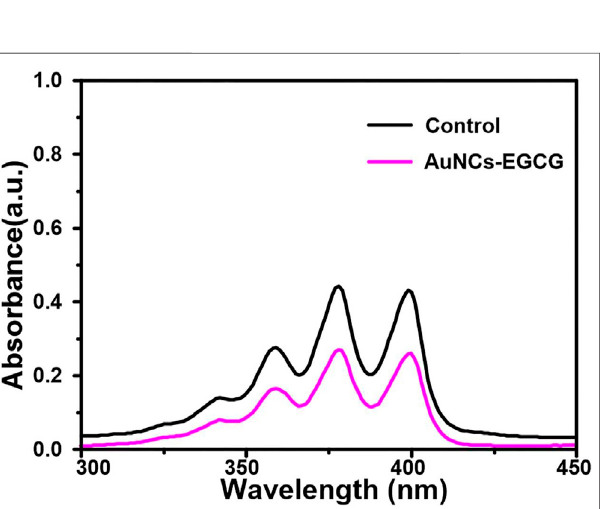
FIGURE 3 | UV spectra of ABDA solution in control group and AuNCs- EGCG group.